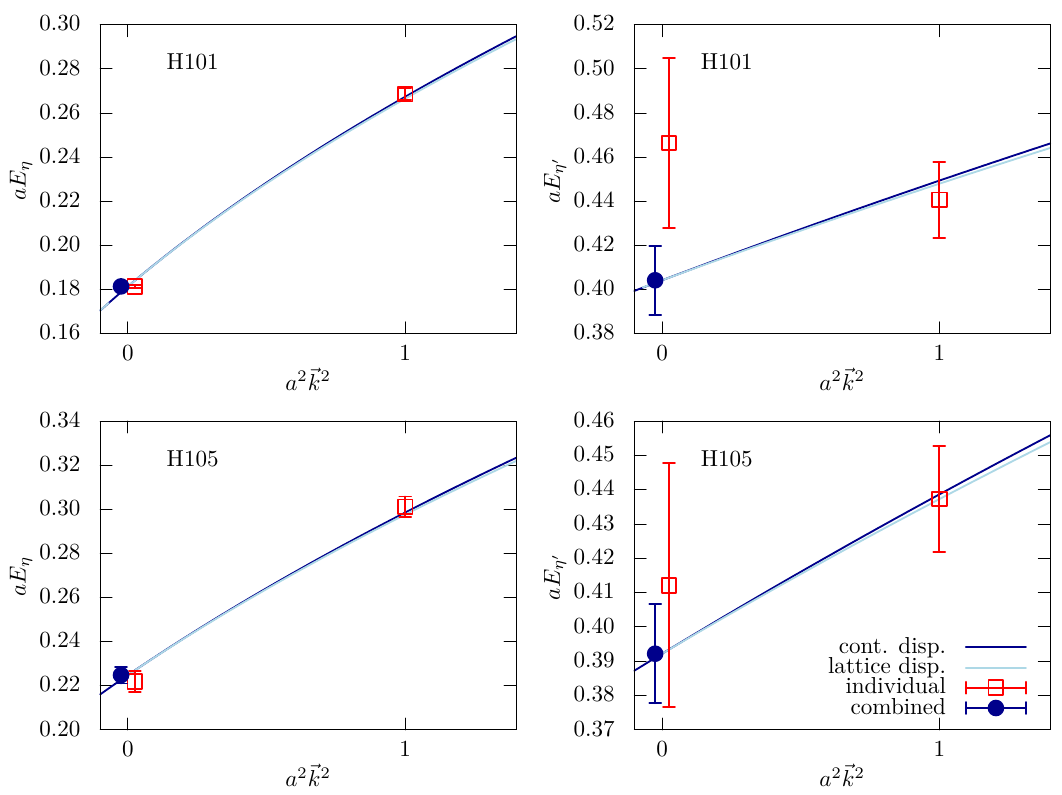
Figure 2. Energies of the η (left panels) and η 0 (right panels) mesons determined on ensembles H101 (top) and H105 (bottom). The red squares display the energies with a 2 ~k 2 = 0 and a 2 ~k 2 = 1 extracted from individual fits, while the blue filled symbols show the masses determined from a combined fit assuming the continuum dispersion relation (dark blue). The lattice dispersion relation (light blue) obtained using the masses extracted from the combined fit is also displayed. The data points at a 2 ~k 2 = 0 have been shifted slightly for better visibility. Note that E η = E π on the symmetric ( m s = m ‘ ) ensemble